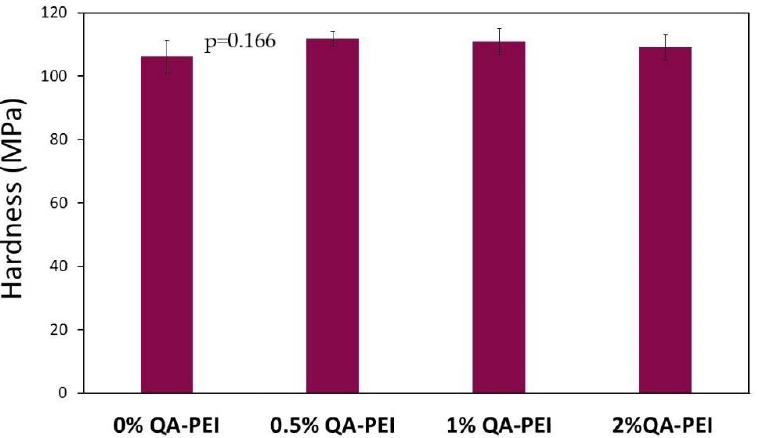
Figure 16. HB values of the materials. All the results for HB were statistically insignificant ( p >